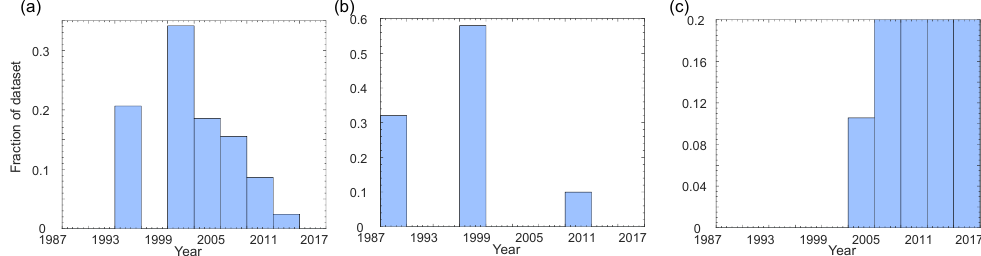
Figure 5. Histograms showing the date taken and associated fraction of the accumulation dataset for each area examined: (a) Antarctica, (b) Greenland excluding Summit Station, and (c) Summit